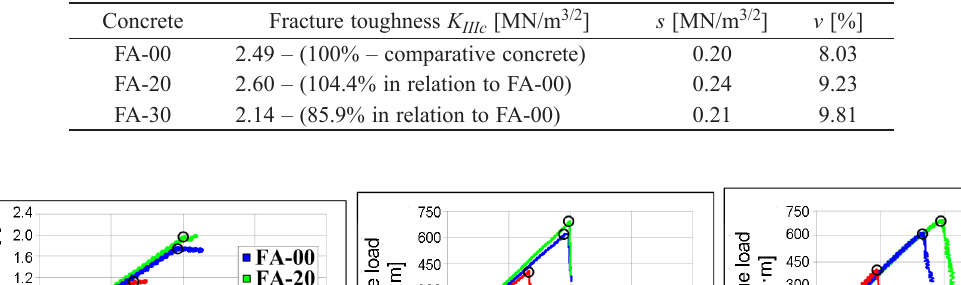
Table 3. Fracture toughness K IIIc of concretes